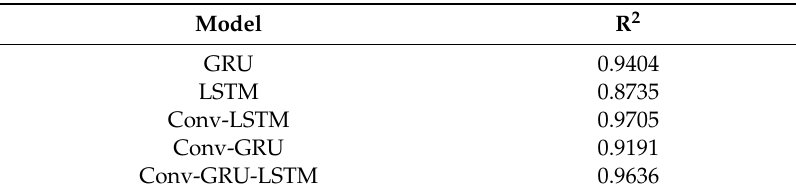
Table 6. Coe ffi cient of